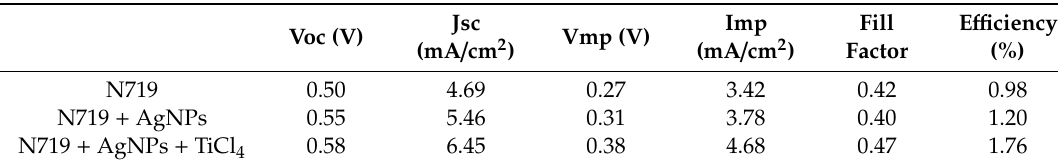
Table 1. Photovoltaic performance for fabricated dye-sensitized solar cell (DSSCs) with and without Silver Nanoparticles (AgNPs).